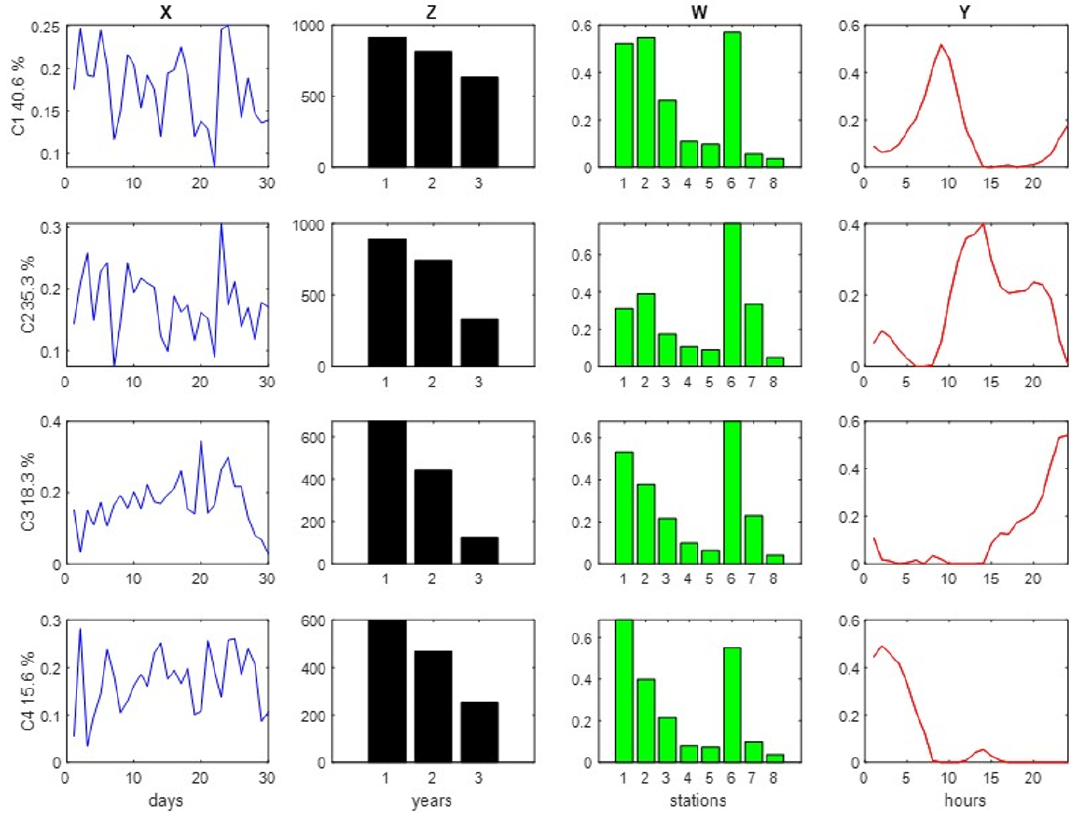
(Eq. 3) using non- 2